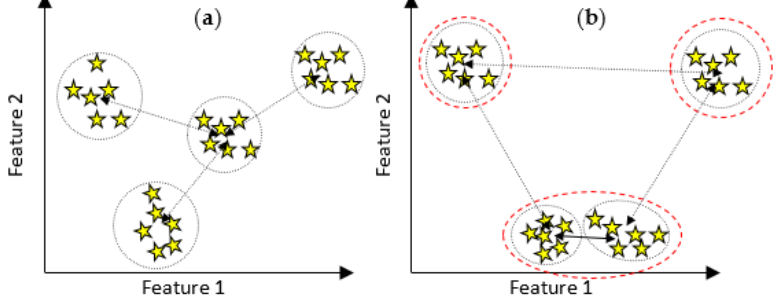
Figure 11. Two cluster distribution examples, ( a ) well separated data into easily identifiable clusters and ( b ) two data groups are in close proximity to each other but far away from the other groups.